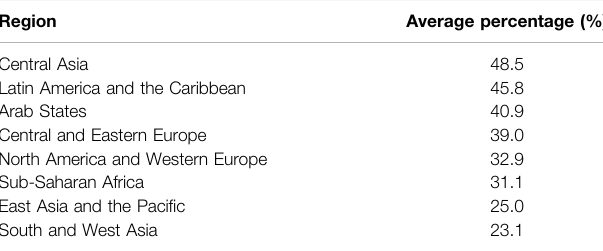
TABLE 1 | The average percentage of females involved in R&D positions (full time and Part time jobs) in different regions globally, according UIS fact sheet (UNESCO Institue for Statistics